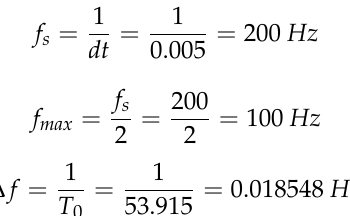
Figure 14. Analysis process for the 10th-story acceleration in the Kobe earthquake using Method 1: ( a ) discrete Fourier Transform of applied load; ( b ) transfer function; ( c ) acceleration; ( d ) velocity; and ( e ) displacement.